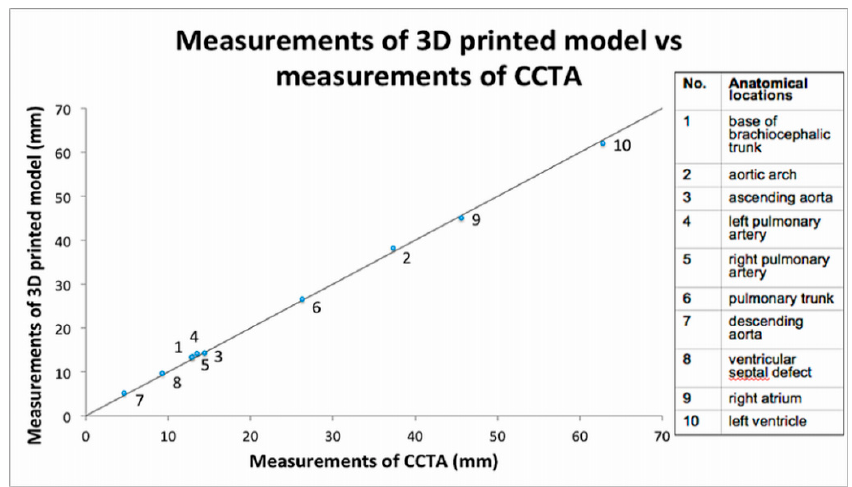
Figure 3. Scatterplot showing measurements of 3D printed model in comparison with those from cardiac computed tomography (CT) images at 10 anatomical locations. CCTA—cardiac computed tomography angiography. Reprinted with permission under the open access from Lau et al. [16].